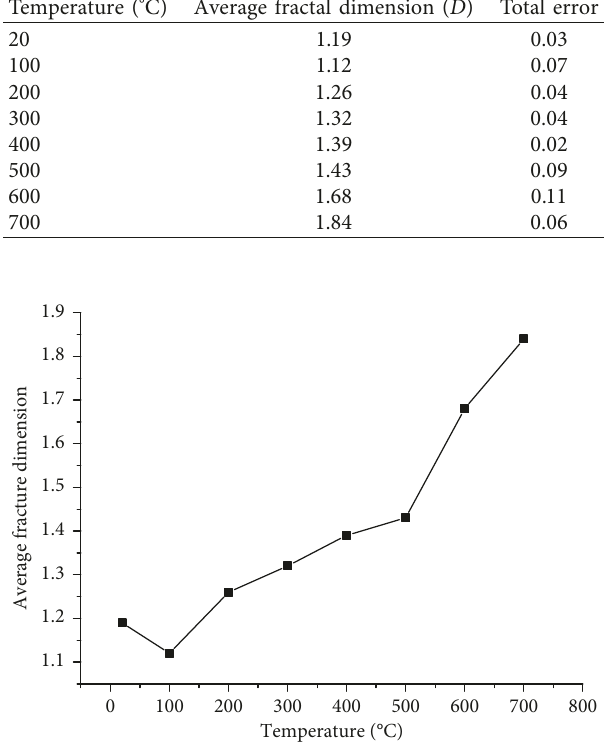
Figure 8: The relationship between average fractal dimension and